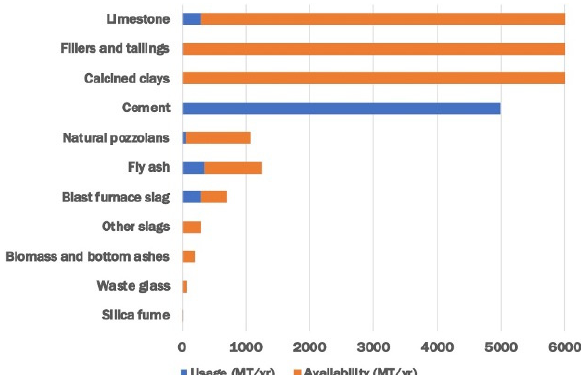
Figure 1. Availability of cement, conventional SCMs, and alternative SCMs (adapted from